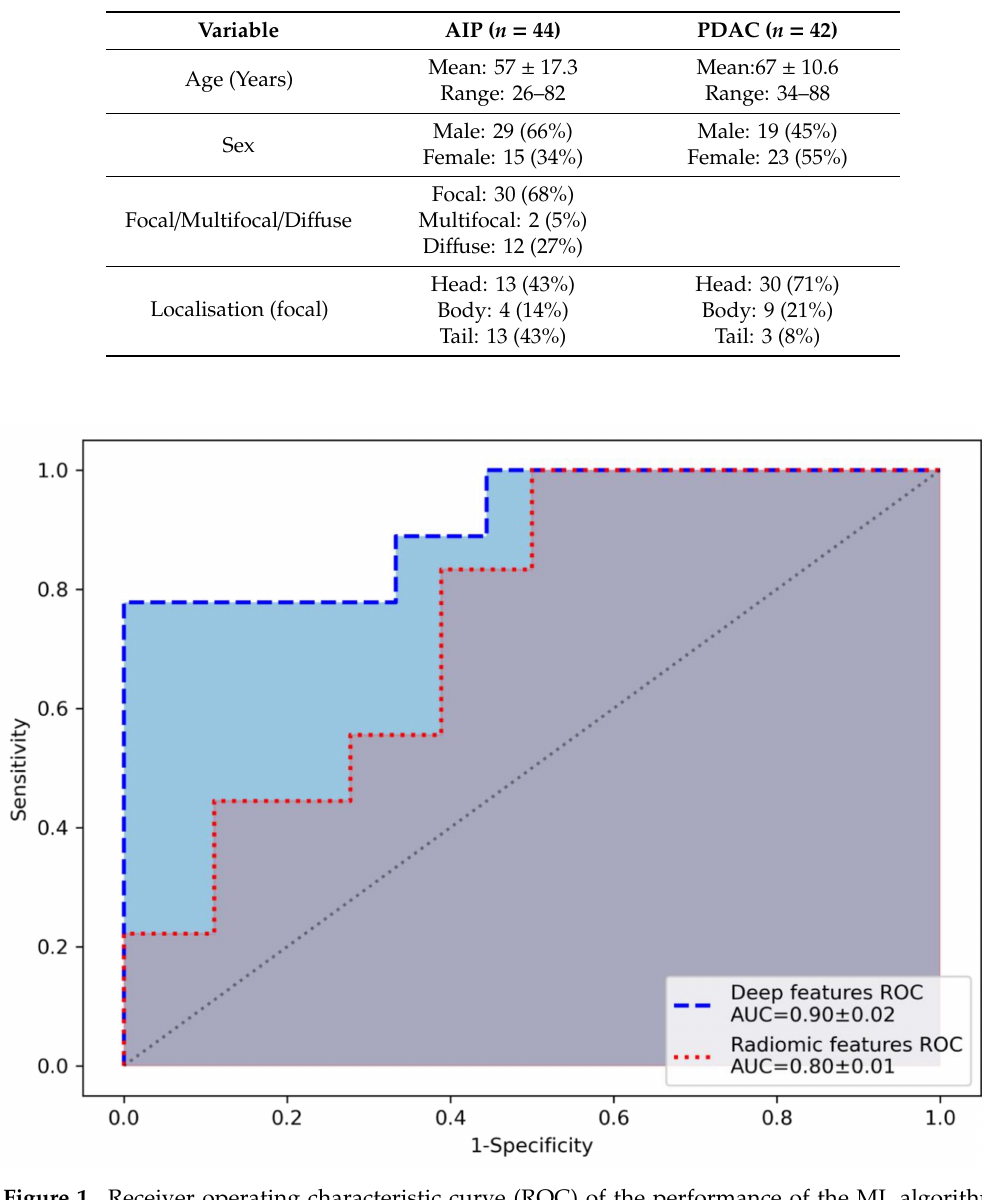
Figure 1. Receiver operating characteristic curve (ROC) of the performance of the ML algorithm, showing an area under the curve (AUC) of 0.9 for the deep features and 0.8 for the radiomic